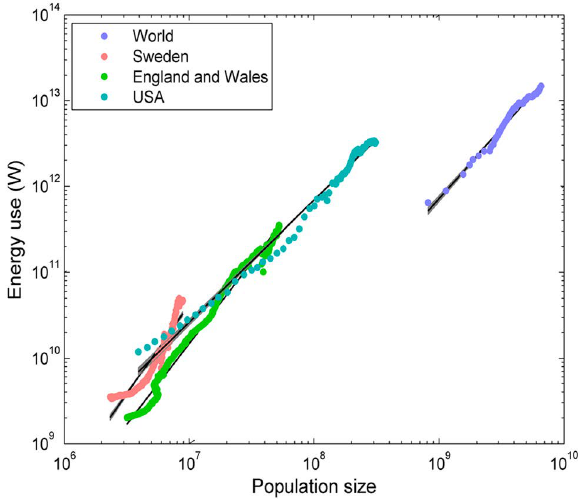
Figure 1. Energy use (W) vs. population size in the world and in selected countries [2].